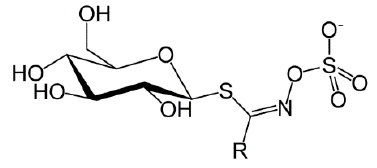
Figure 1. Structure of glucosinolates, where R is the variable side chain from amino acids [9].